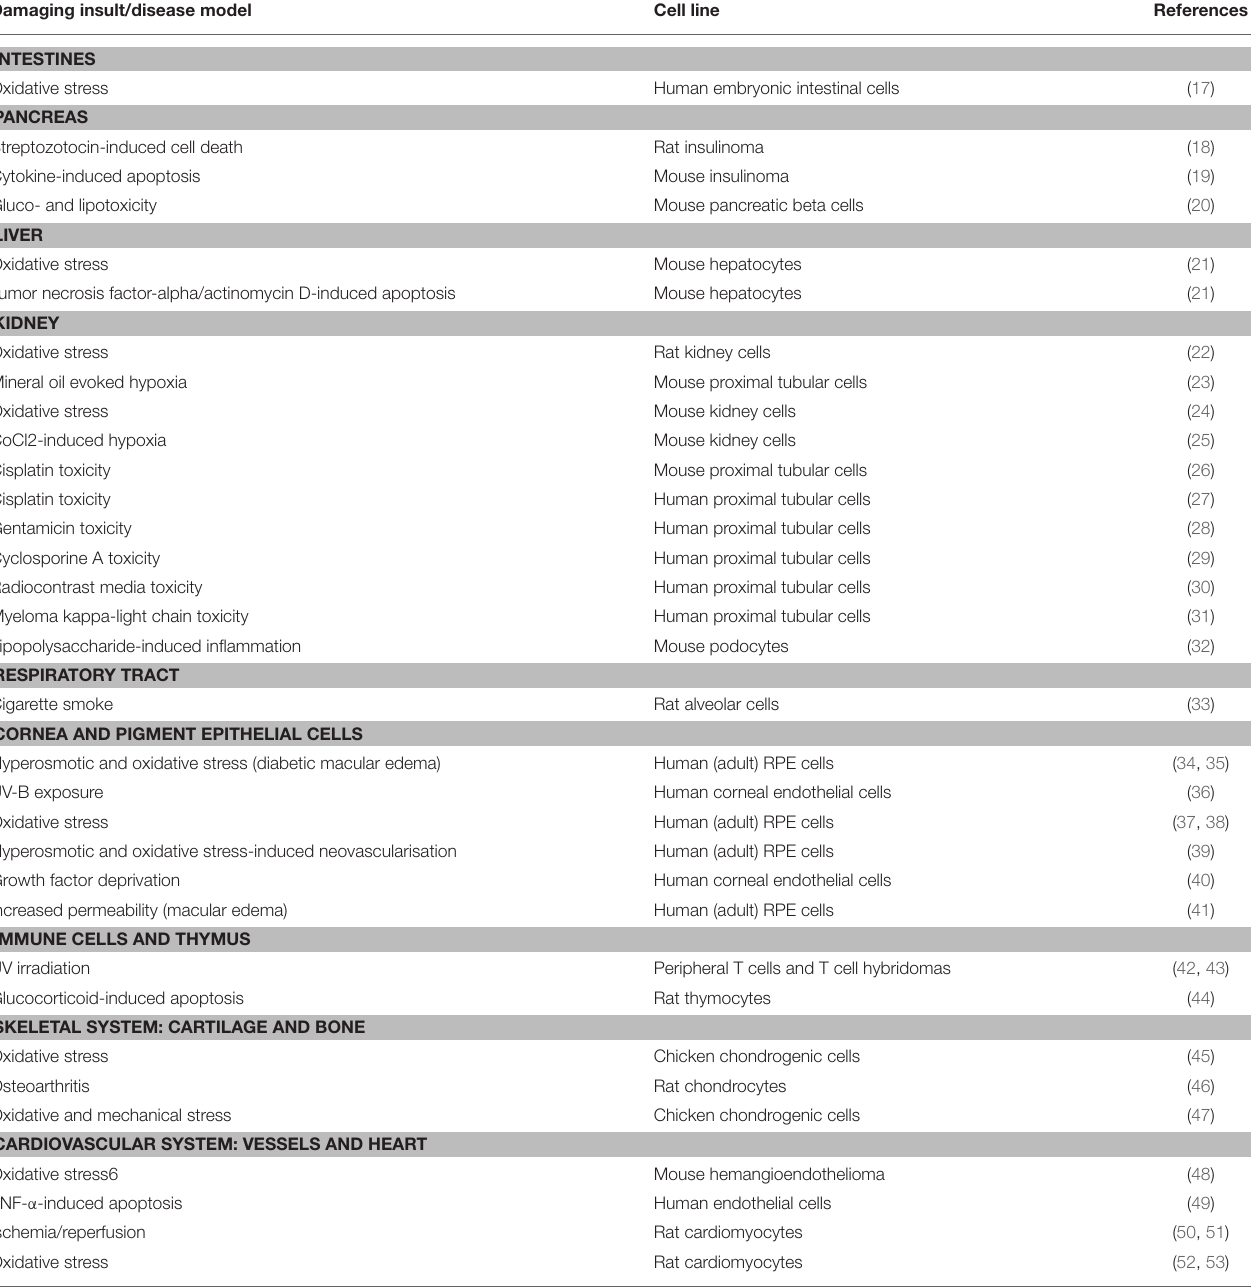
TABLE 1 | In vitro studies showing protective effects of